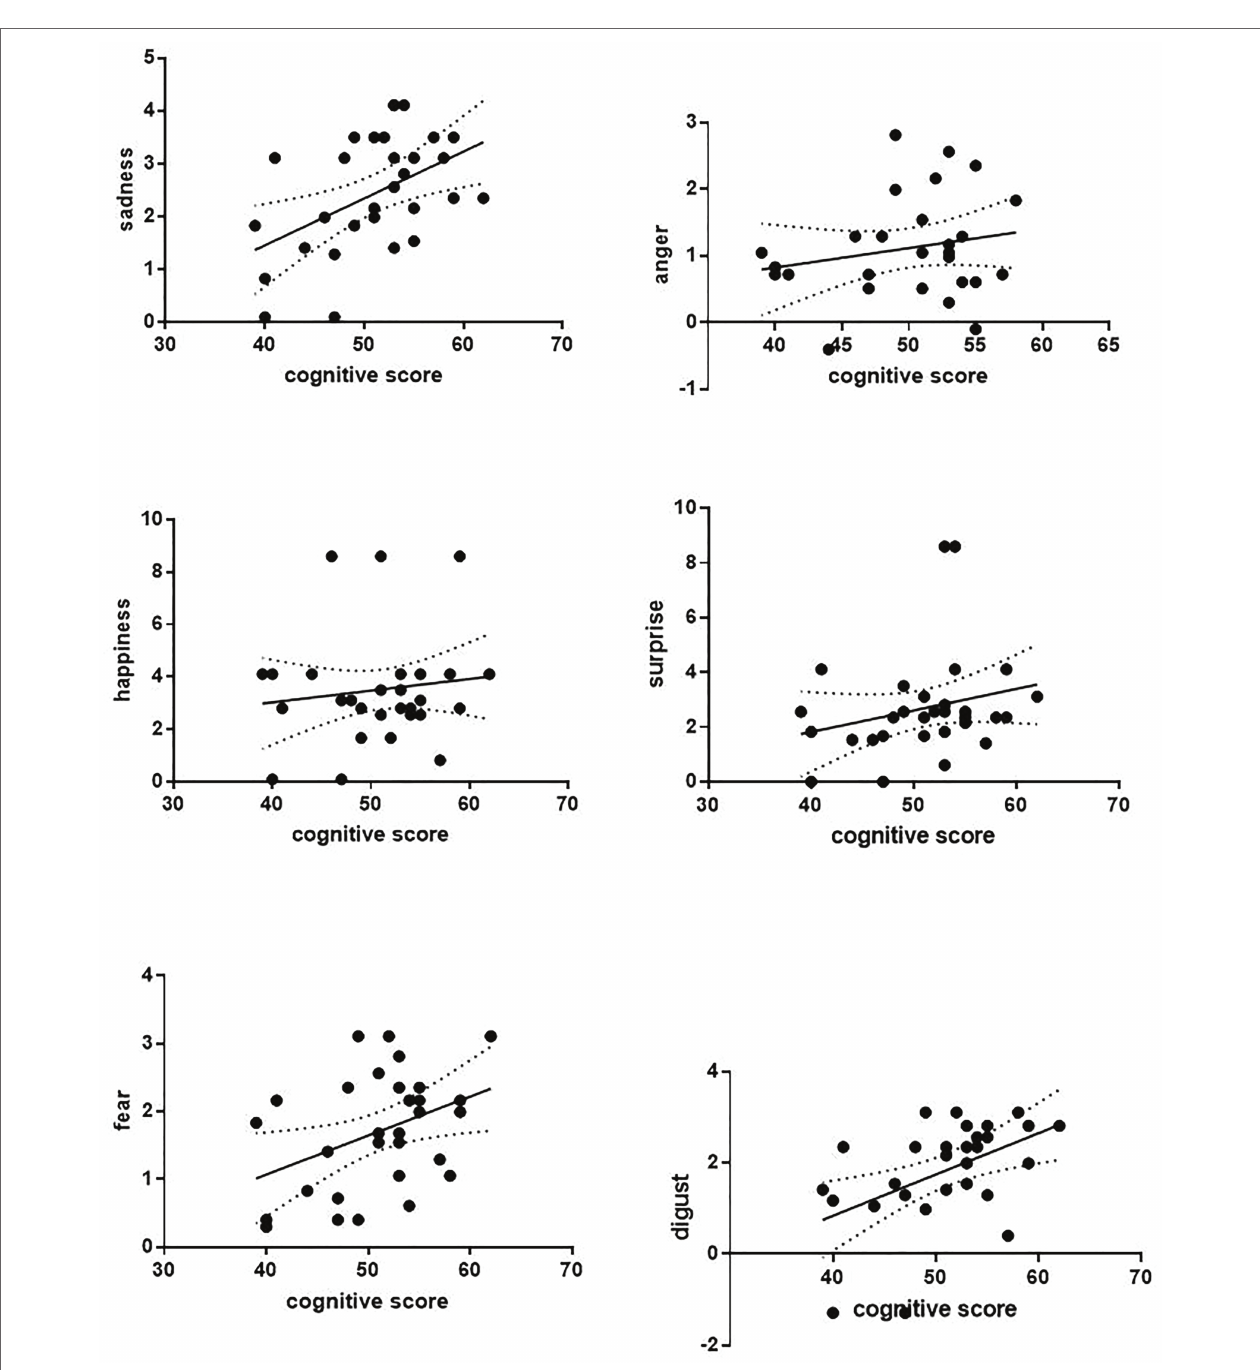
FIGURE 4 | Correlation relationship between facial expression recognition and cognitive